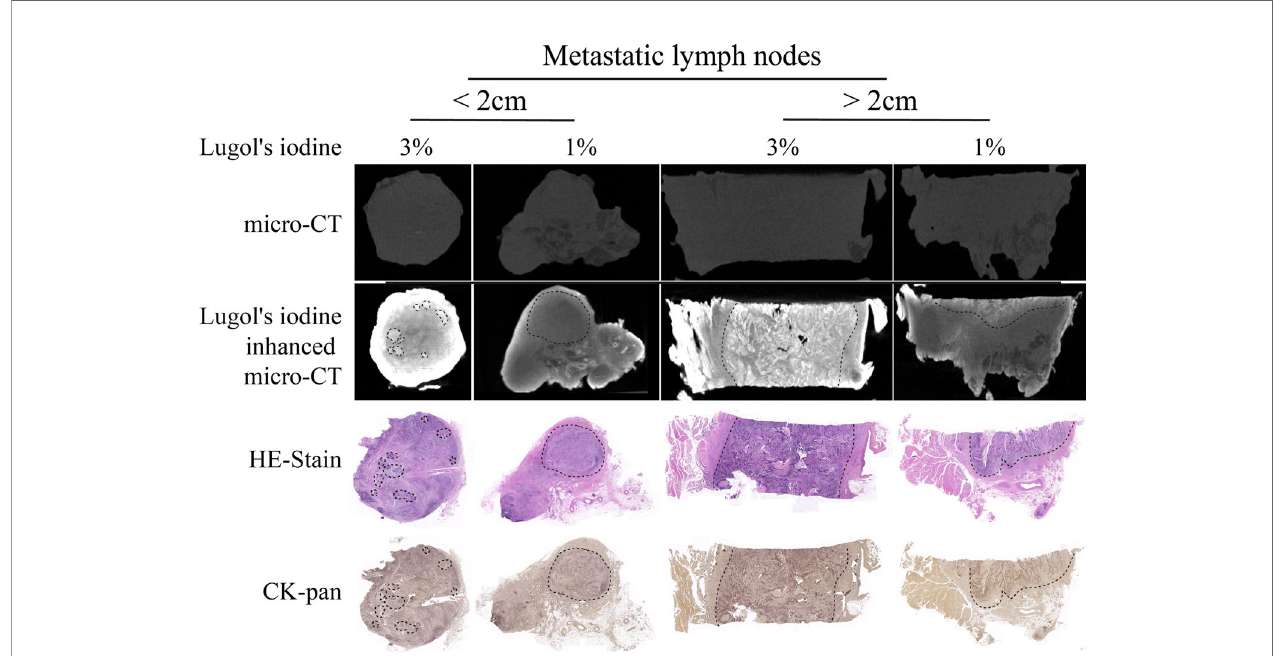
FIGURE 4 | I 2 -IK-enhanced micro-CT imaging before paraf fi n embedding for clinical OSCC regional metastatic LNs. After comparing the image of I 2 -IK-enhanced micro-CT with simple micro-CT image, we found that I 2 -IK could enhance the contrast between metastatic tumor tissues and normal LNs tissues and 3% I 2 -IK staining acquired better effect then 1% I 2 -IK. In addition, after comparing the image of I 2 -IK-enhanced micro-CT with subsequent pathological image, the region of high CT value was highly correlated with tumor tissues.